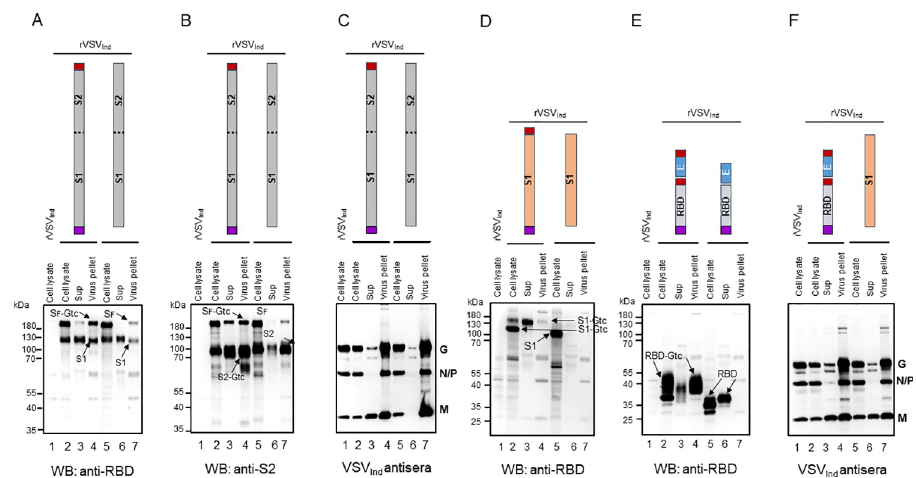
Fig 3. Incorporation of S F , S1, S2, and RBD proteins with VSV Gtc into rVSV Ind viral particles. Incorporation of SARS-CoV-2 S F , S1, S2, and RBD with or without VSV Gtc into rVSV Ind particles was examined by infecting BHK-21 cells with rVSV Ind -SARS-CoV-2 at an MOI of 3. The rVSV Ind -SARS-CoV-2 infected cells were incubated at 31˚C for 6 hrs. Infected cell lysates were prepared in lysis buffer (lanes 1, 2, and 5). Culture media from the infected cells was centrifuged at 500 x g for 10 minutes and supernatant was filtered through a 0.45 μ m filter to remove cell debris. The filtered culture media was loaded onto 1 ml of 25% sucrose cushion and ultra-centrifuged at 150,900 x g for 3 hrs. Supernatant on top of the 25% sucrose cushion was collected to check the soluble proteins in the media (lanes 3 and 6). Pelleted samples were checked for proteins incorporated into VSV particles (lanes 4 and 7). We detected RBD, S1, and S F proteins by Western blot using an antibody against the SARS-CoV-2 RBD protein. S2 and S F proteins were detected by rabbit antibody against SARS-CoV-2 S2. (A) Detection of S F and S1 proteins in cell lysate, concentrated culture media, and virus pellet from cells infected with rVSV Ind -msp-S F -Gtc or rVSV Ind -S F . (B) Detection of S F and S2 proteins in cell lysate, concentrated culture media, and virus pellet from cells infected with rVSV Ind -msp-S F -Gtc or rVSV Ind -S F . (C) Detection of VSV Ind proteins in cell lysate, concentrated culture media, and virus pellet from cells infected with rVSV Ind -msp-S F -Gtc or rVSV Ind -S F . (D) Detection of S1 protein in cell lysate, concentrated culture media, and virus pellet from cells infected with rVSV Ind -msp-S1-Gtc or rVSV Ind -S1. (E) Detection of RBD proteins in cell lysate, concentrated culture media, and virus pellet from cells infected with rVSV Ind -msp-RBD-Gtc+E-Gtc or rVSV Ind -msp-RBD+E. (F) Detection of VSV Ind proteins in cell lysate, concentrated culture media, and virus pellet from the cells infected with rVSV Ind -msp-RBD-Gtc+E-Gtc or rVSV Ind -msp-RBD+E. Purple box: honeybee msp, red box: VSV